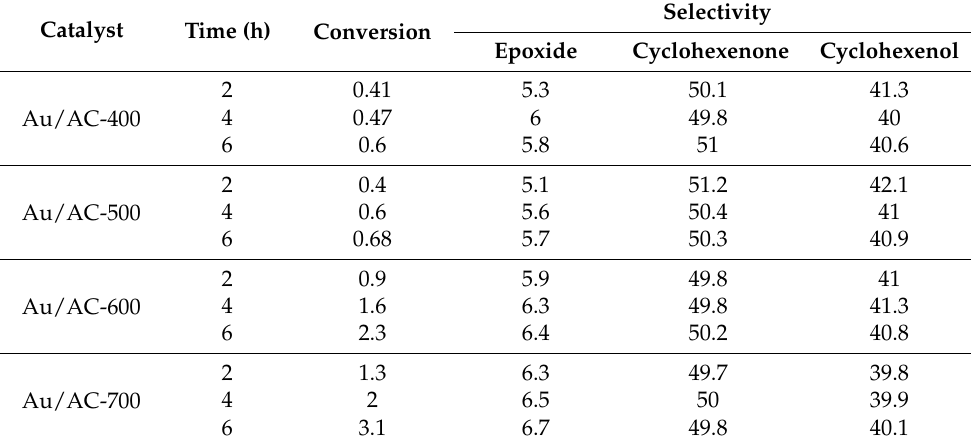
Table 2. Oxidation of cyclohexene using 1% Au/AC catalyst. Catalyst Time